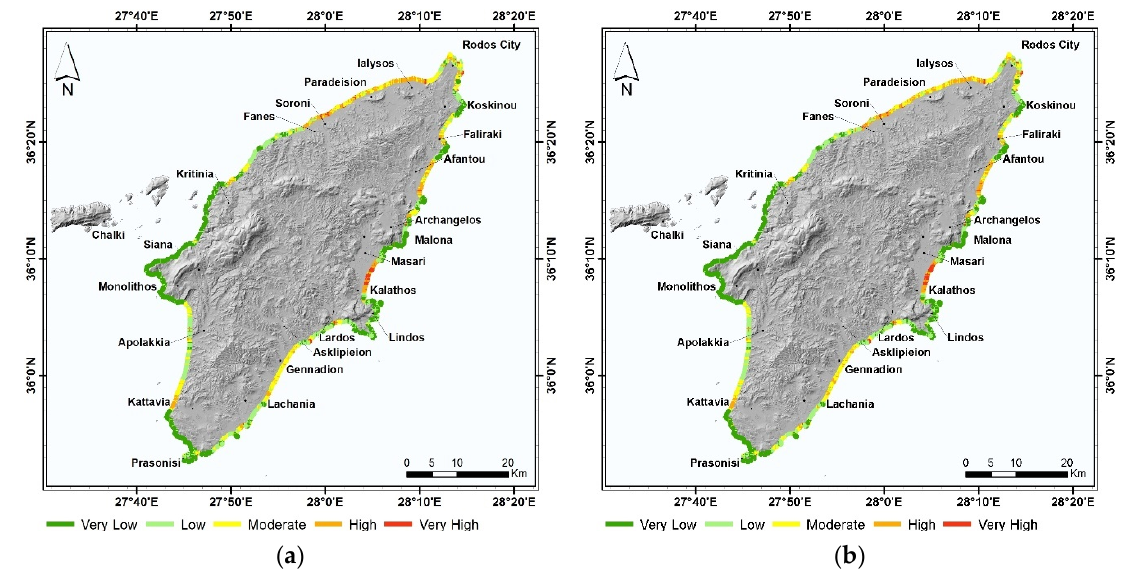
Figure 7. Evaluation of the relative vulnerability due to coastal slope in Rhodes Island: ( a ) The current situation and ( b ) condition projected to 2100.